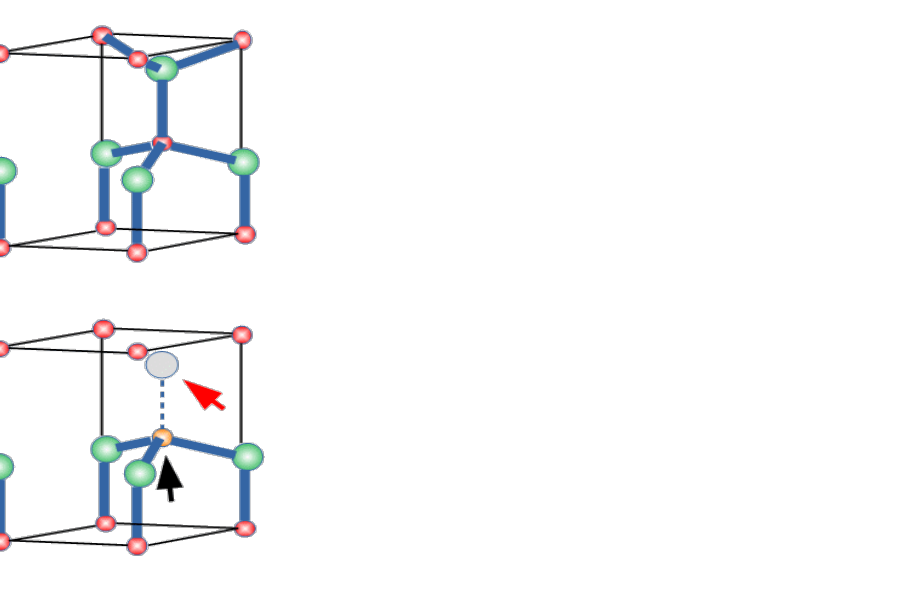
Figure 1. ( a ) ZnO Wurtzite structure. Red and green spheres represent Zn and O atoms, respectively. ( b ) The black and red arrows indicate the positions of a Co atom (orange sphere) substituting a Zn one and a missing O atom (grey sphere) in a Co-V O complex, respectively.